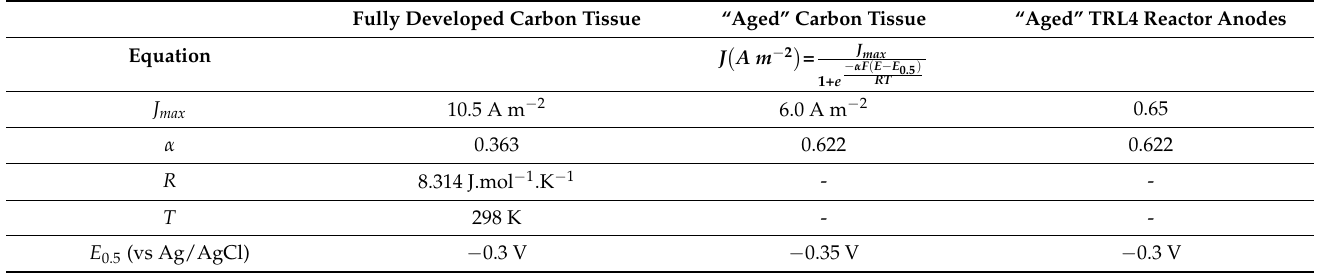
Figure 3. ( A ) The integral system, ( B ) the reactor body with electrodes and membrane frames, ( C ) the reactor body with liquid injection pipes and gas diffusers and the reactor body with electrodes, ( D ) membrane frames, and the center block. Table 1. Equation and parameters used for performance modeling of the active bioanode and the “aged”